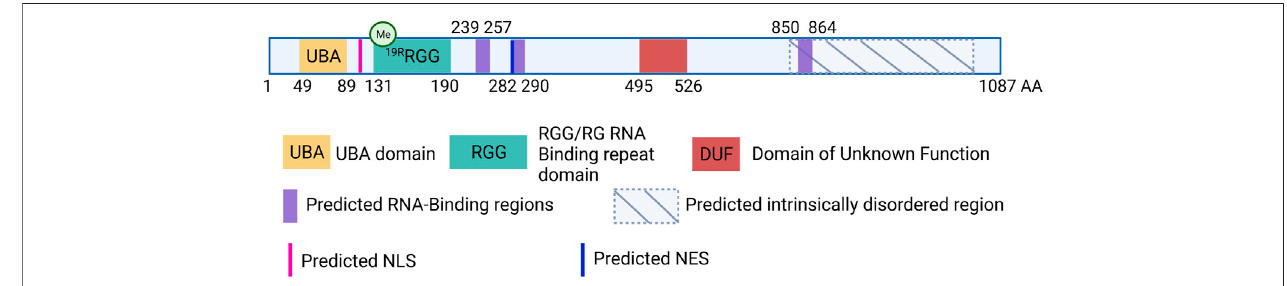
FIGURE 1 | Schematic view of the human UBAP2L protein and its domain organization. UBAP2L (1087 AA) is composed of a Ubiquitin-associated domain (UBA, yellow), an Arginine-Glycine-Glycine (RGG, green) domain and a Domain of Unknow Function (DUF, red). Additional RNA-binding regions have been predicted and are painted in purple. Moreover, UBAP2L is predicted to contain several Nuclear Localization Signals (NLS) and Nuclear Export Signals (NES) (pink and dark blue respectively). Several UBAP2L regions have been proposed to be intrinsically disordered (IDR), and prone to liquid-liquid phase-separation. The most conserved ones are shown with hatched lines. It is important to note that for simplicity we chose to depict only some of the predicted NLS, NES and IDR regions of UBAP2L in the scheme, and that this does not exclude the existence of other similar motifs or regions. Similarly, documented methylation modi fi cation on 19 different arginines (19R) present within the RGG domain has been indicated